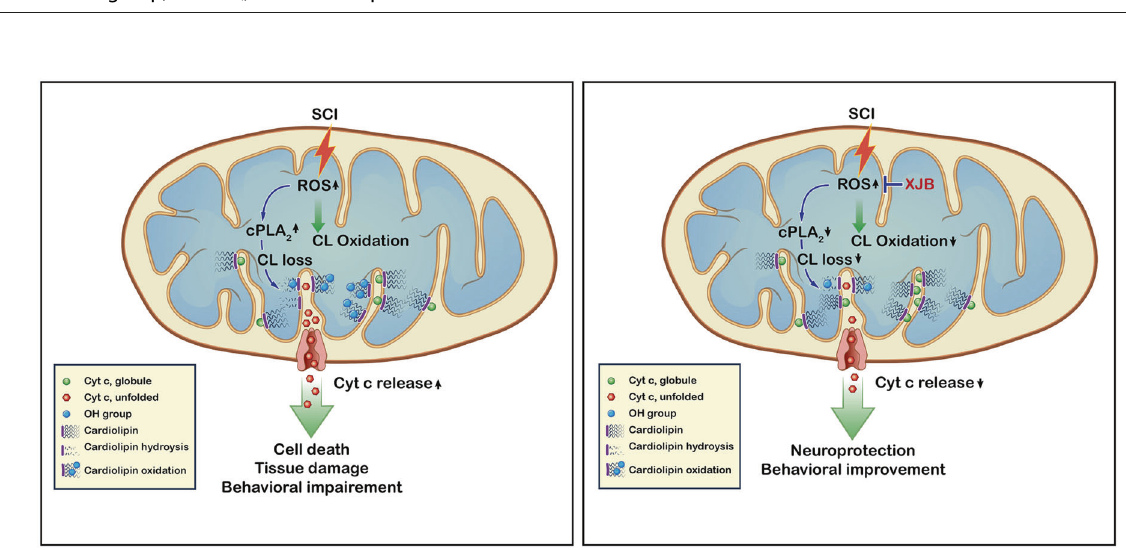
Fig. 8 Role of cardiolipin (CL) in spinal cord injury (SCI). Schematic drawing shows that SCI-induced CL alterations (peroxidation and loss) and downstream cascades leading to apoptotic cell death and functional impairment. Under normal circumstances, cardiolipin binds and retains cytochrome c (cyt c) in its native molten-globule structure at the inner mitochondrial membrane, keeping it close to the electron transport chain. (Left) During SCI, however, a massive production of ROS leads to accumulation of unfolding of cyt c, enhancing cyt c ’ s peroxidase activity, which targets polyunsaturated acyl chains of CL and induces CL peroxidation. ROS also induces cPLA 2 activation, which hydrolyzes CL and induces CL loss. Oxidation and loss of CL weakens and decreases its interaction with cyt c, which is now released and escapes to the cytosol